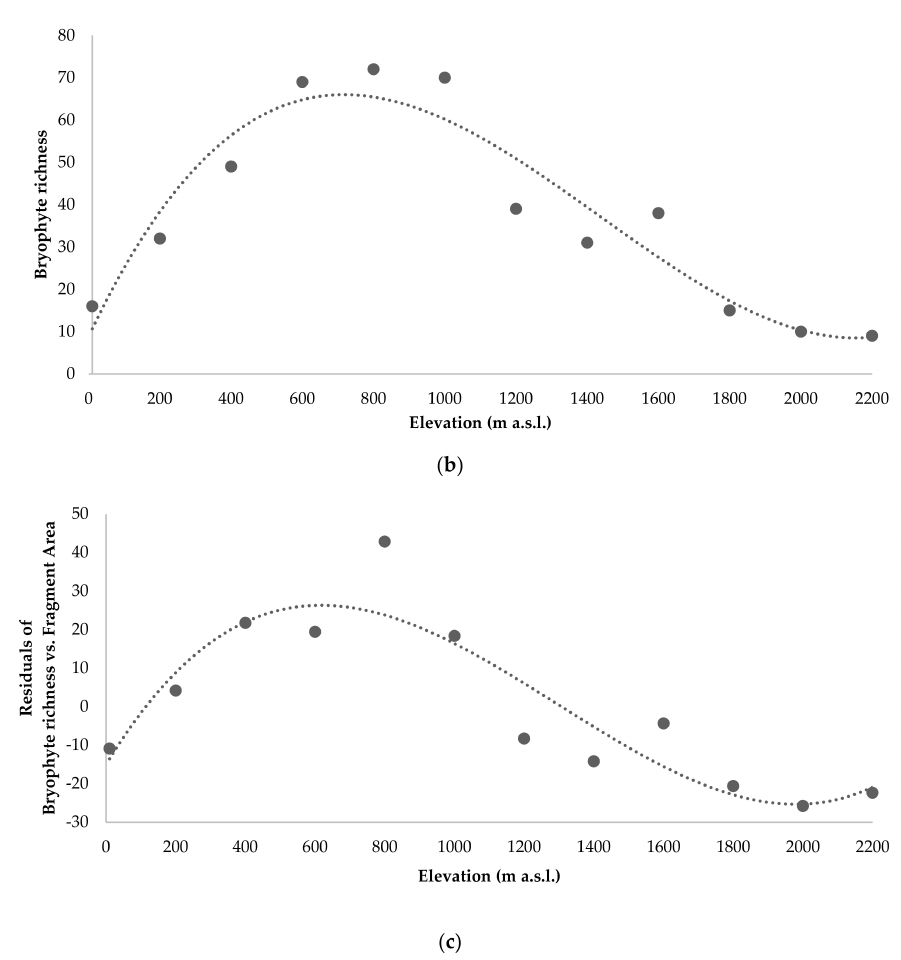
Figure 3. ( a) Bryophyte (liverworts and mosses) richness and abundance (number of presences in 50 cm 2 microplots; see the secondary axis) and vascular plant richness along Pico Island’s elevational gradient (S = number of species; A = number of samples). ( b ) Bryophyte species richness in relation to elevation. The fitted, dashed line resulted from a polynomial regression model. ( c ) Residuals of bryophyte species richness versus fragment area (ha) in relation to elevation. The fitted, dashed line results from a polynomial regression model. See the text for further details and